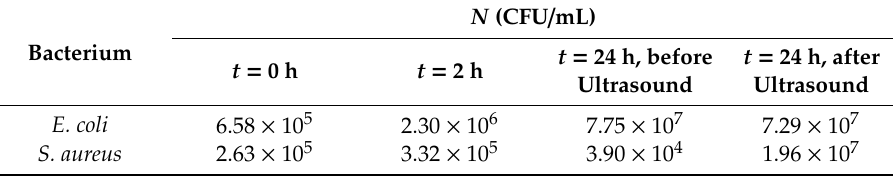
Table 2. Number of viable bacteria cells, N , for E. coli and S. aureus incubated in the presence of the LI(100) sample for di ff erent periods of time, t , as well as before and after 10 min of ultrasound treatment.